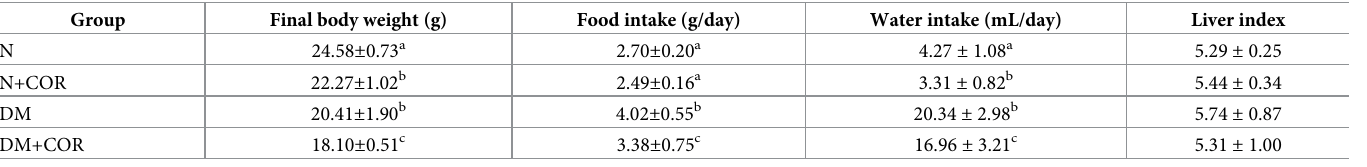
Values are expressed mean ± SD. Different letters indicates statistically significant differences between groups ( P <